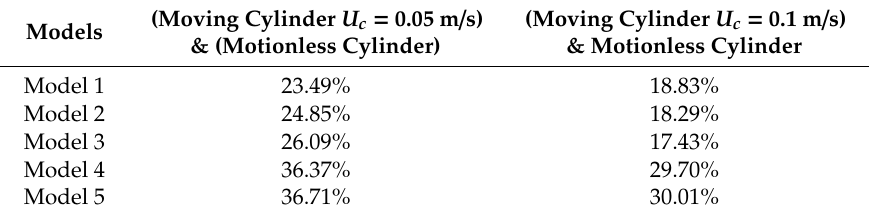
Table 4. Percentages of maximum hydrodynamic force between unmoved and moving